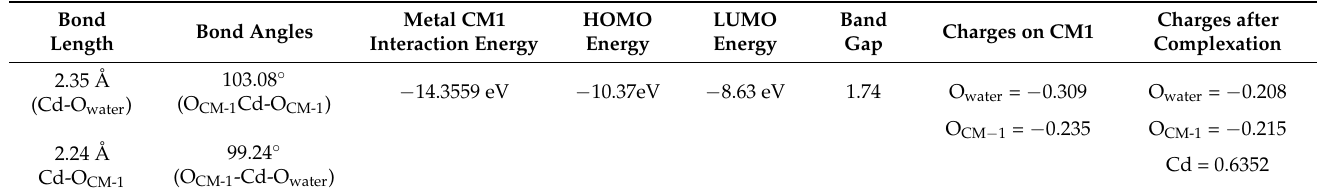
Table 2. Binding energies of CM1 and its Cd 2+ complex.